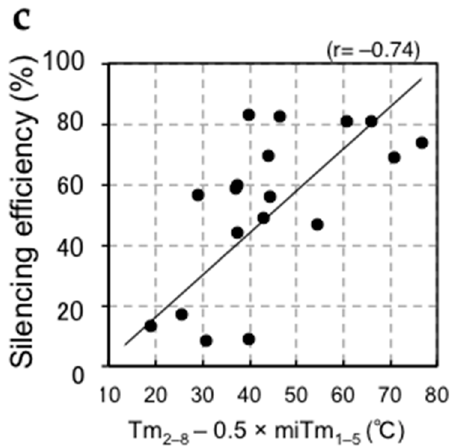
Figure 2. Relationships between silencing efficiency and thermodynamic parameters. The y -axis means the silencing efficiency, indicating the value (%) subtracted the measured luciferase activity (%) from 100. ( a ) The calculated T m-value of the duplex formed between the siRNA seed region and target mRNA ( T m 2–8 ) showed a positive correlation with siRNA-mediated silencing efficiency; ( b ) The calculated T m 2–8 values showed a marginal correlation with miRNA-mediated silencing efficiency; ( c ) The miRNA-mediated silencing efficiency showed a strong positive correlation with the parameter composed of T m 2–8 and miRNA 5 ′ -terminal stability (mi T m 1–5 ), shown as T m 2–8 − 0.5 × mi T m 1–5 .